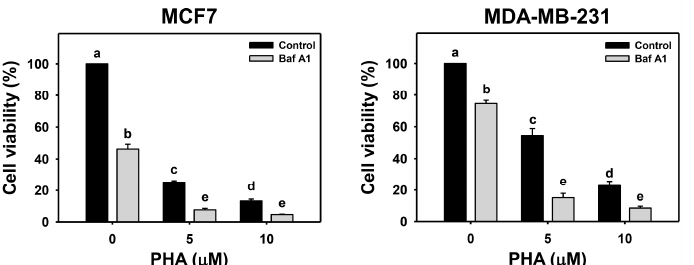
Figure 1. Autophagy downregulation reduces the cell viability of PHA-treated breast cancer cells. Cell viability was assessed by ATP level after 24 h of drug treatment. Breast cancer cells (MCF7 and MDA-MB-231) were co-treated with PHA (0 (control), 5, and 10 μM) and Baf A1 (0 (control) and 100 nM) for 24 hours, namely Baf A1/PHA. Data were expressed as means ± SDs ( n = 3). Data with non-overlapping lower-case letters differ significantly ( p < 0.05 to 0.0001).